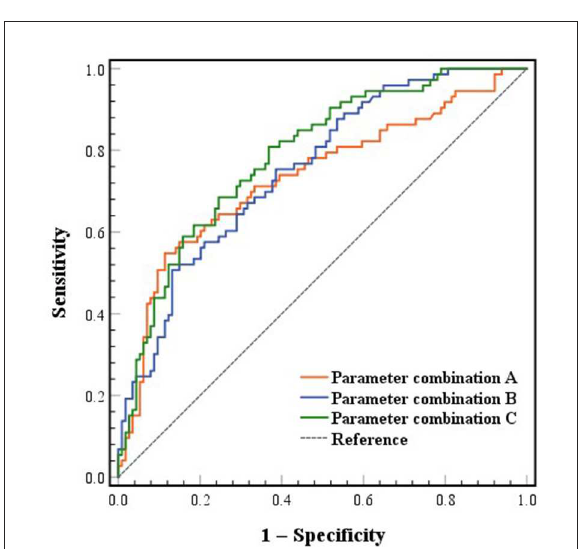
FIGURE3 ROC curves of combined parameters predicting poor functional outcome at 3 months. ROC, receiver operating characteristic. Parameter combination A included World Federation of Neurosurgical Societies (WFNS) grade and admission white blood cell (WBC). Parameter combination B included WFNS grade and postoperative red blood cell distribution width (RDW) and mean platelet volume (MPV). Parameter combination C included WFNS grade, admission WBC and postoperative RDW and